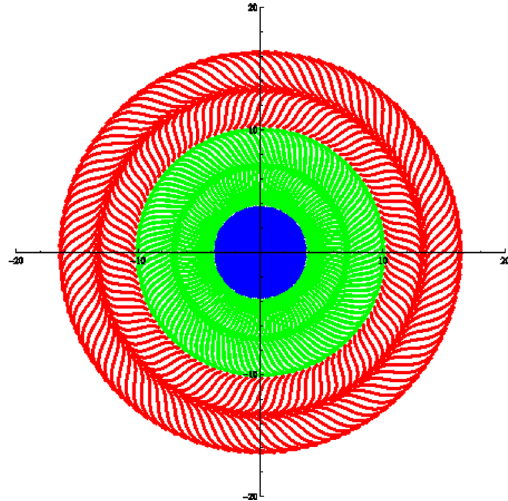
2. The phase space portrait of the longitudinal oscilla- tions showing evolution of the particle trajectories (in normal- ized coordinates) starting from different initial conditions. Different colors correspond to regions with different fixed points (or circles) with values of ’ ¼ 0 , 2 (cid:2) , and 4 (cid:2)